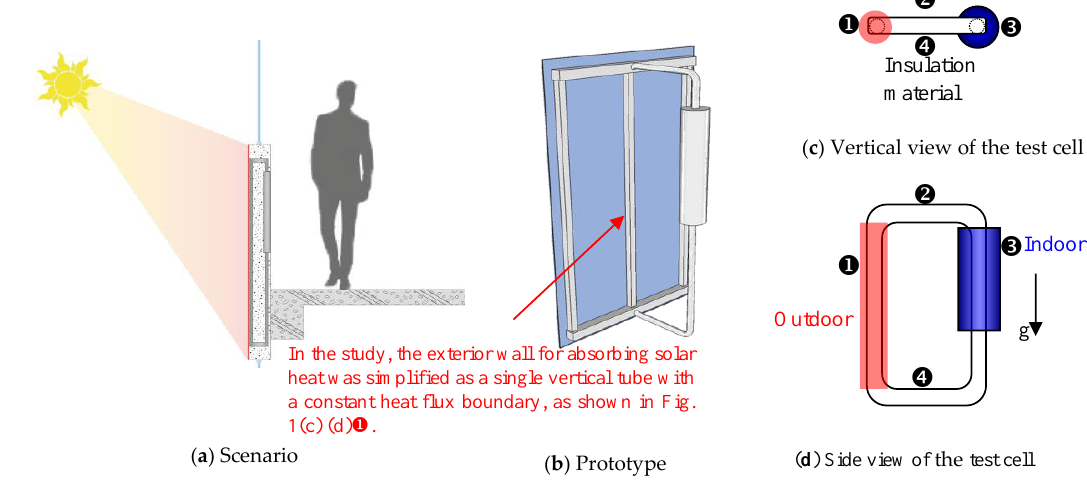
Figure 1. Scenario, prototype development, and test cell illustration.